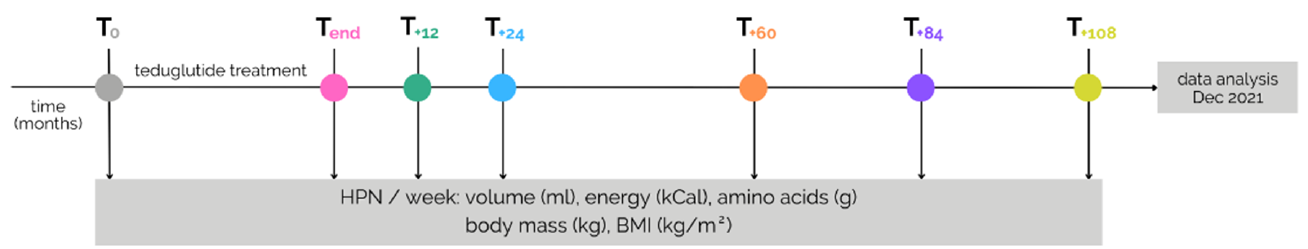
Figure 1. Study design and